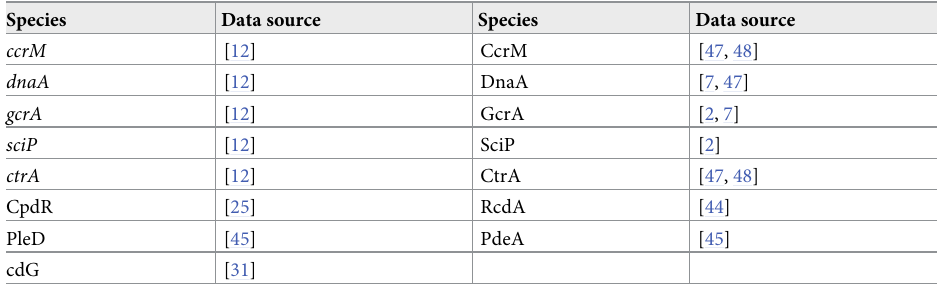
Integrating the hierarchical proteolysis (Fig 5) into the master regulatory network (Fig 3), we propose a model to capture the temporal dynamics of cell cycle regulators and glean insights about bacterial protein proteolysis systems. Non-uniform distributions of molecules in space are ignored at this stage. Table 5. Sources for experimental data used to evaluate our